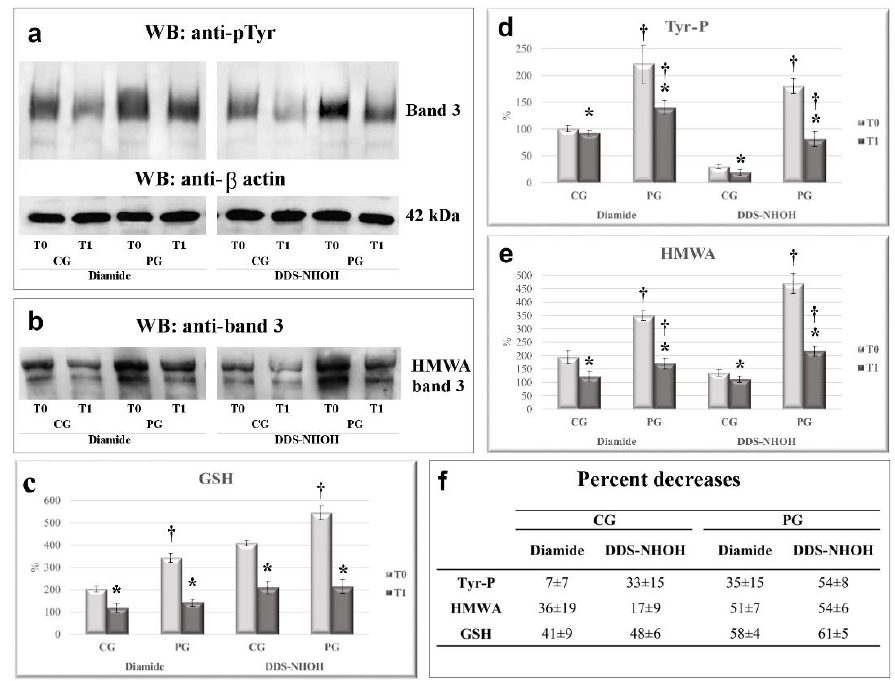
Figure 3. The effect of 1-week licorice intake on the Tyr-P level ( a ), HMWA, ( b ) and membrane GSH contents ( c ), following diamide or DDS-NHOH stimulation, in the CG and PG groups. RBCs from CG and PG were incubated with 1.5 mM diamide or 0.30 mM DDS-NHOH. The membranes (10 µ g) obtained, as described in Methods, were analyzed by Western blotting and immunostained with the anti-P-Tyr antibody and then with anti- β actin as a loading control (Panel a ). The membranes were also analyzed in non-reducing conditions and immunostained with anti-band 3 (Panel b ) or anti-GSH (not shown) antibodies, in order to evidence the band 3 high molecular weight aggregate (HMWA) and bound glutathione, respectively. The figure is representative of the study population. For each immunostaining, bands corresponding to the relative proteins were densitometrically estimated and statistically analyzed GSH values of diamide or DDS-NHOH treated RBCs were calculated as the ratio percentage to GSH levels obtained in the basal samples of CG at T 0 (chosen as an arbitrary comparison unit, experimentally determined as 101 ± 3%) (Panel c ). The Tyr-P value of diamide—or DDS-NHOH—treated RBCs before (T 0 ) and after a week of licorice intake (T 1 ) was calculated as: Tyr-P% = (Tyr-P(x)/Tyr-P(CG) diamide T 0 %, with the Tyr-P value obtained in diamide samples of CG at T 0 chosen as an arbitrary comparison unit (experimentally determined as 100 ± 5%) (Panel d ). The band 3 HMWA of diamide or DDS-NHOH treated RBCs were calculated as the ratio percentage to band 3 HMWA obtained in the basal samples of CG at T 0 (chosen as an arbitrary comparison unit, experimentally determined as 100 ± 4 and) (Panel e ). (Panel f ) average percent decrease for each parameter, referring to the corresponding values at T 0 , were calculated and reported. Data show the means ± SD of n = 12 healthy subjects (CG) and n = 18 patients (PG). Comparison from the respective T 0 values: * p < 0.005, Student’s t -test for paired data. Comparison CG vs PG: † p < 0.001, Student t -test for unpaired